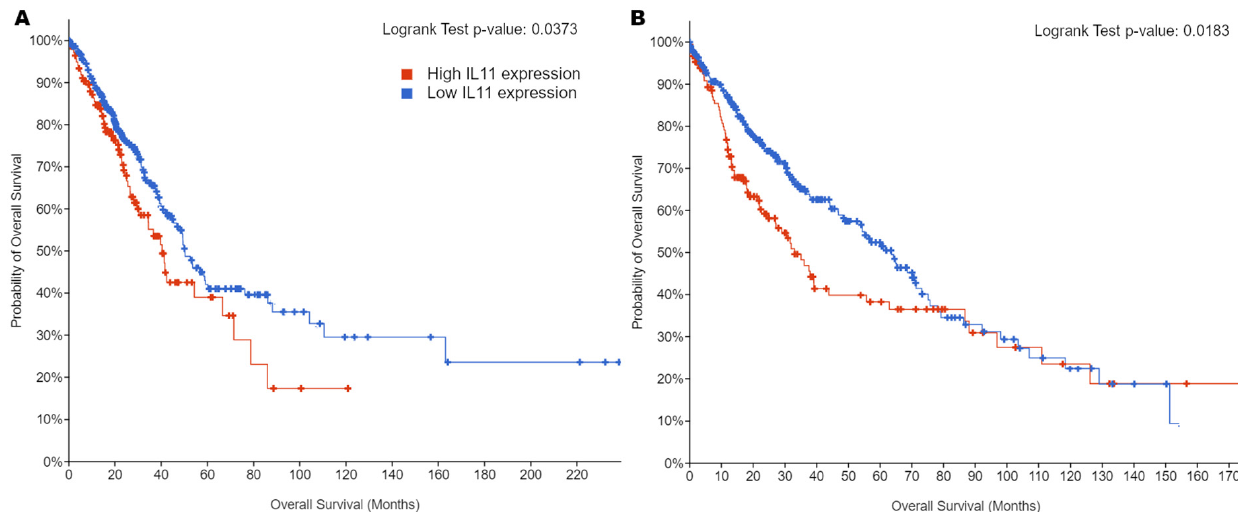
Figure 2. Kaplan–Meier curves for overall survival in patients with either high or low tumor IL11 mRNA expression in the TCGA PanCancer Atlas datasets for ( A ) LUAD (n = 501) and ( B ) SCC (n = 478). A cutoff of z > 0 was used for high expression and z ≤ 0 as low expression. Logrank tests show statistically significant differences between the high and low expression groups. The results shown here are based upon data generated by the TCGA Research Network [75,116], generated with cbioportal (https://www.cbioportal.org) [113,117] that was last accessed on 26 April 2022.